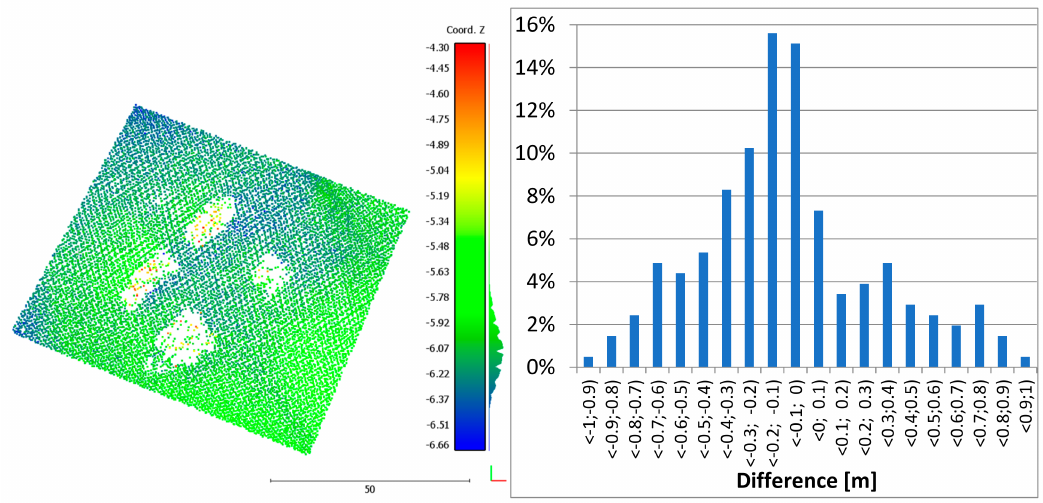
Figure 9. Distribution of di ff erences between new points in the point cloud on the bottom and data from multiband